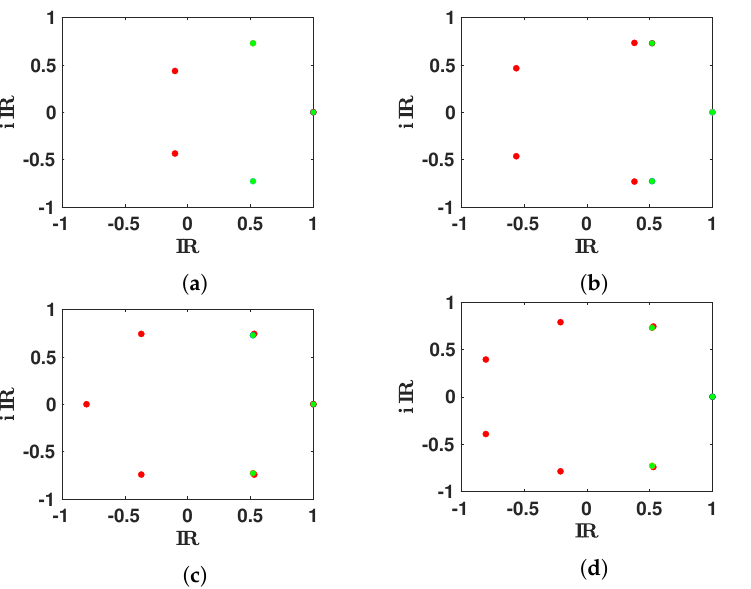
Figure 7. We plot the spectrum of the Markovian Leslie matrices L (red dots) when n = 3,5,6,7, (respectively in ( a – d )) giving the best match to the secondary eigenvalues λ (cid:63) We observe that the best fit of the two secondary eigenvalues remain far away from λ (cid:63) n = 3, then get closer for n = 5, and are very close for n = 6 and n =